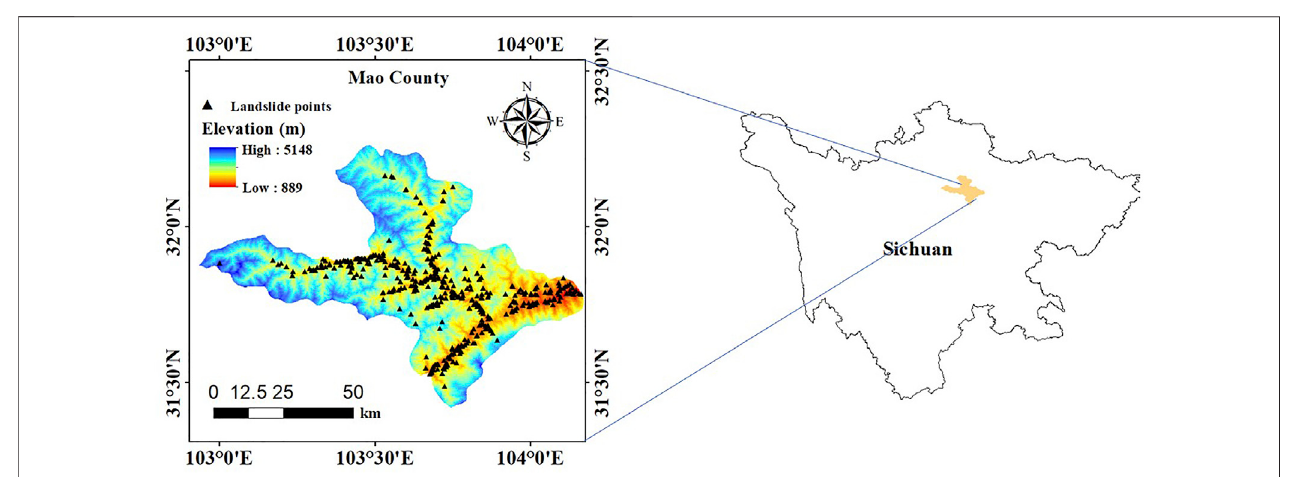
FIGURE 1 | The location and geological disaster points of Mao County,